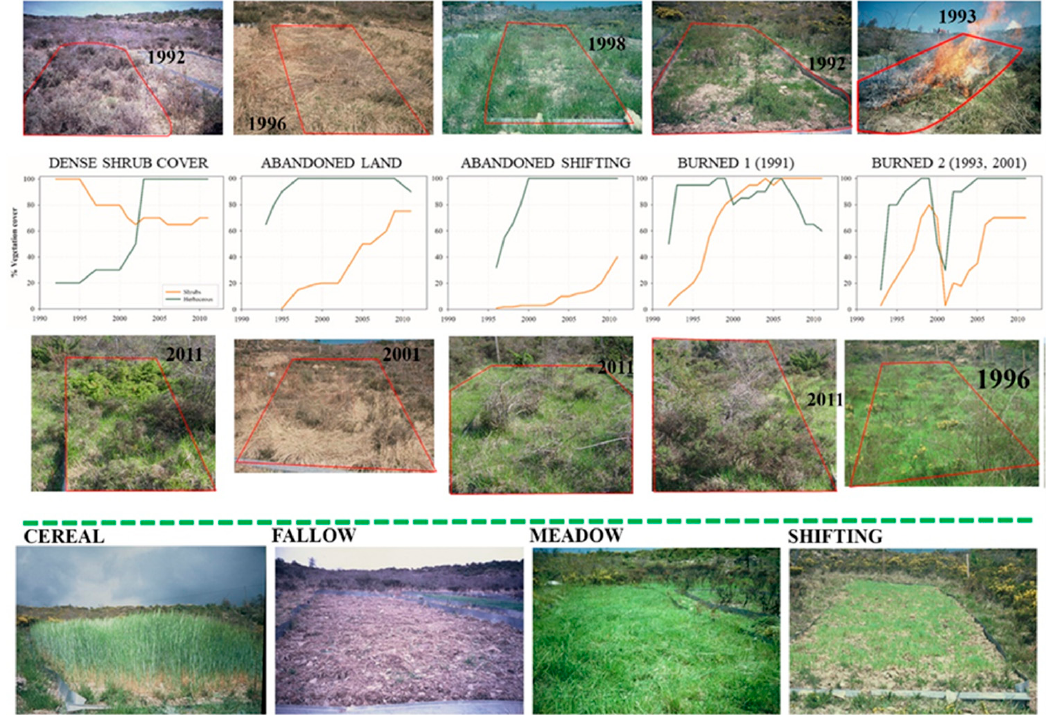
ff erent land uses in two di ff erent